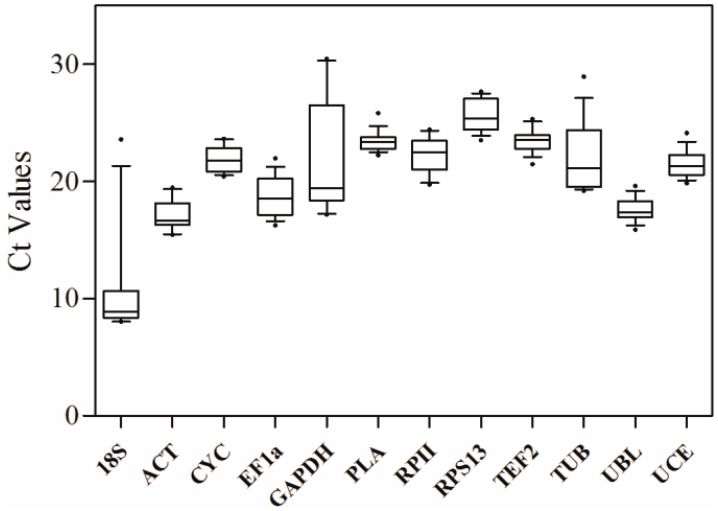
Figure 2. Average cycle threshold ( C t ) values for the twelve candidate reference genes. Boxes indicate the interquartile range. Lines across the boxes indicate the average C t values. Whiskers represent 95% confidence intervals, and black dots represent